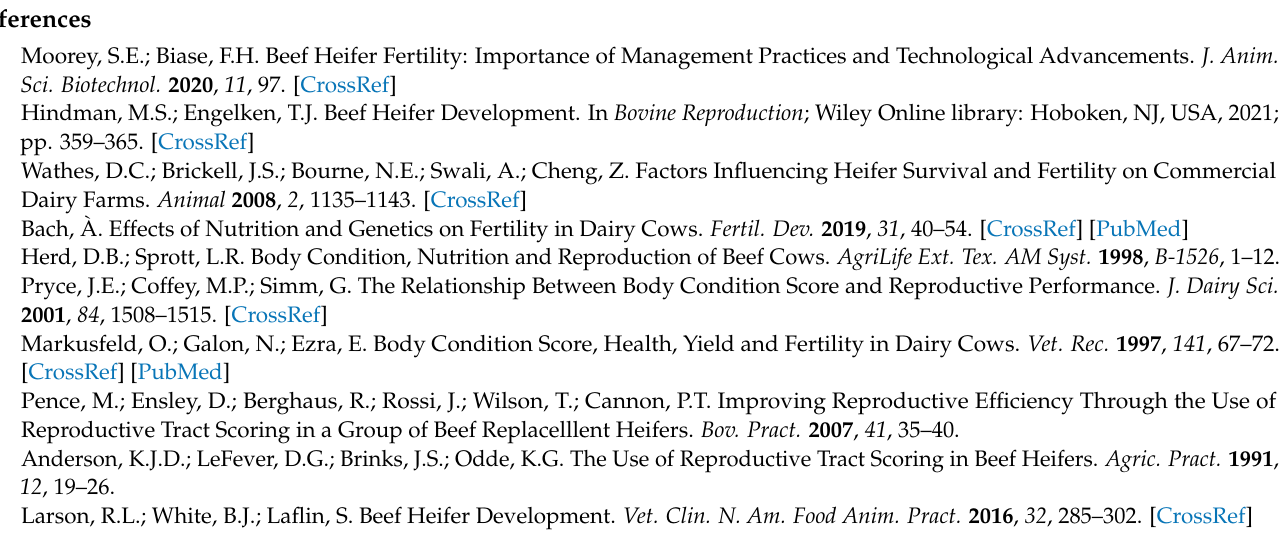
nonpregnant heifers. Table S2: The genes correlated with 38 DEGs identified with the PCIT approach, with correlation ≥ 0.99. Table S3: Network analysis of genes co-expressed with DEGs in AI-pregnant and nonpregnant groups. The hub genes for each group are highlighted in bold. Table S4: Central reference network, including AI-pregnant and nonpregnant groups constructed using 1095 nodes. The genes highlighted in bold have a z-score of ± 1.96; the connectivity is given as gain or loss in the nonpregnant group. Table S5: Pathway over-representation analysis with significant genes from AI-pregnant and nonpregnant. Table S6: The metabolites correlated with 15 DEMs identified with the PCIT approach, with correlation ≥ 0.90. Table S7: Network analysis of metabolites co-expressed with DEMs in AI-pregnant and nonpregnant groups. The hub metabolites for each group are highlighted in bold. Table S8: Central reference metabolite network, including AI-pregnant and nonpregnant groups constructed using 37 nodes. The genes highlighted in bold have a z-score of ± 1.96; the connectivity is given as gain or loss in the nonpregnant group. Table S9: The gene–metabolite pairs correlated with significant targets (8 in AI-P and 22 in NP) identified with the PCIT approach, with correlation ≥ 0.75. Table S10: Significant pathways enriched by gene–metabolite pair identified from PCIT. Table S11: Gene–metabolite pairs by IntLIM